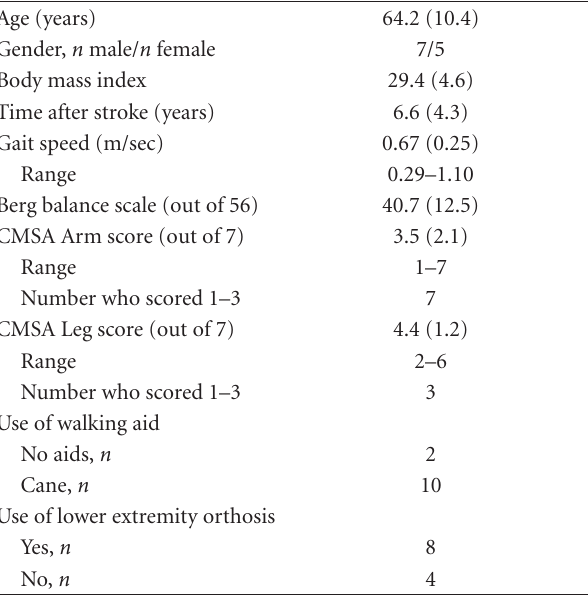
Table 1: Participant